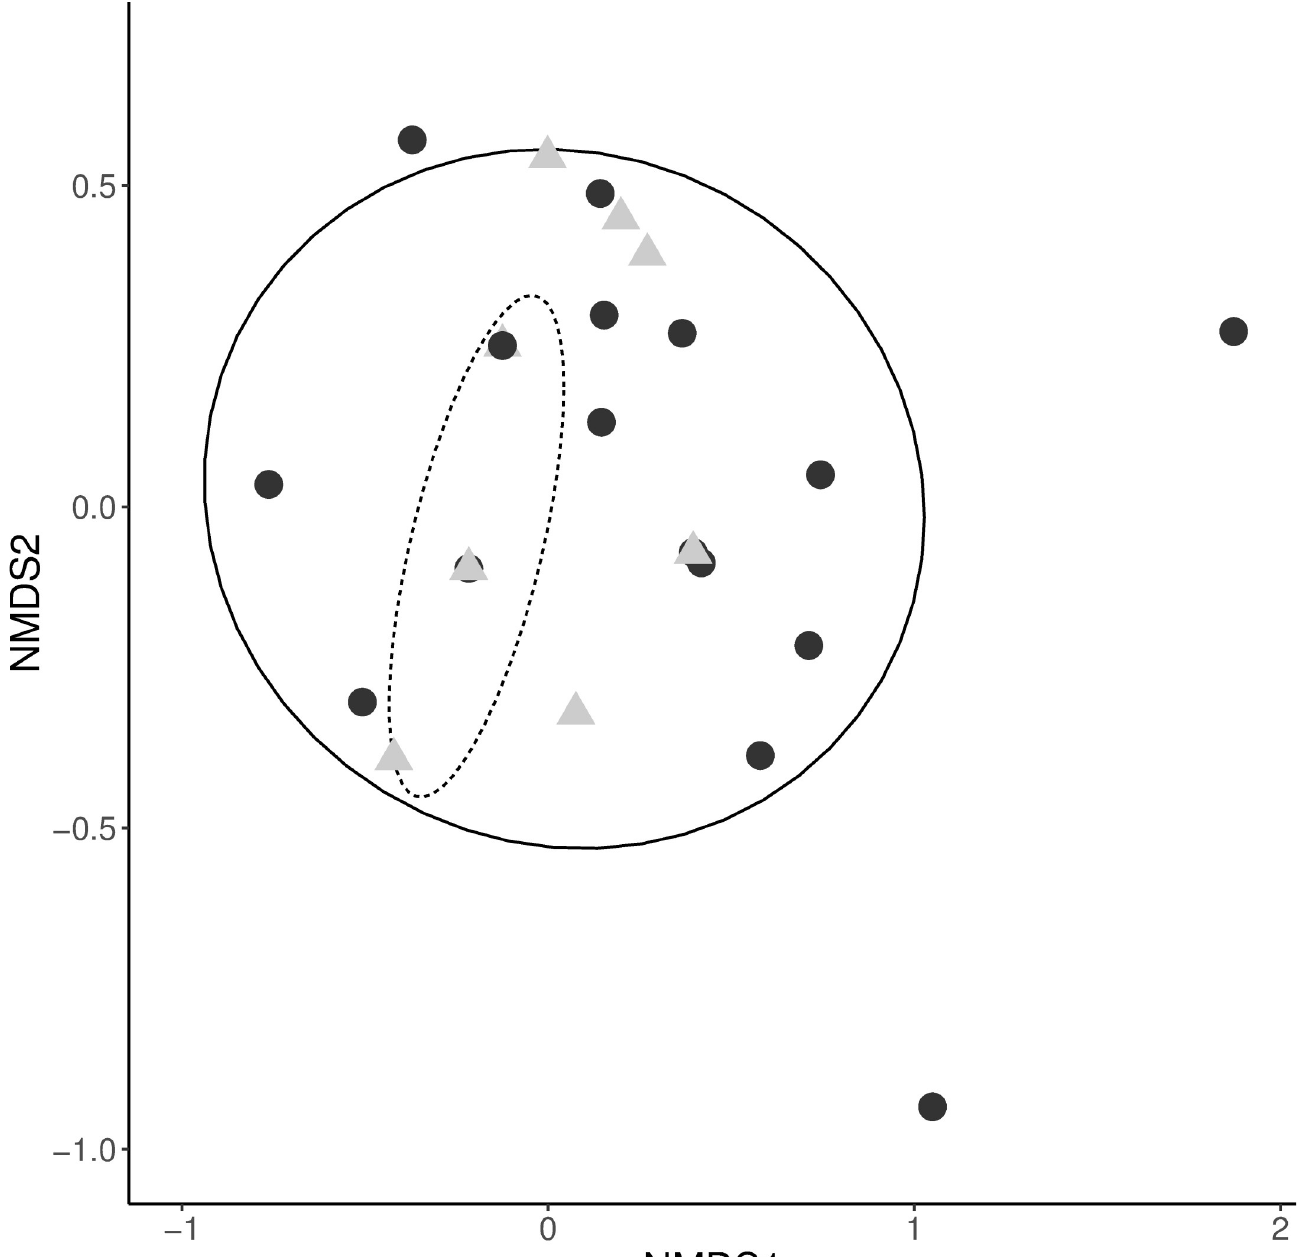
Fig 3. NMDS ordination graph for the two hand-sampled ladybird species. Comparing aphid prey species composition. Full line with points are C . septempunctata , grey triangles with the dashed line are H . axyridis (stress = 0.06), circles indicate a 95% confidence interval.